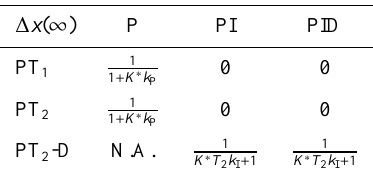
Table 6. Static deviation from ideal compensation for all considered sensor-controller